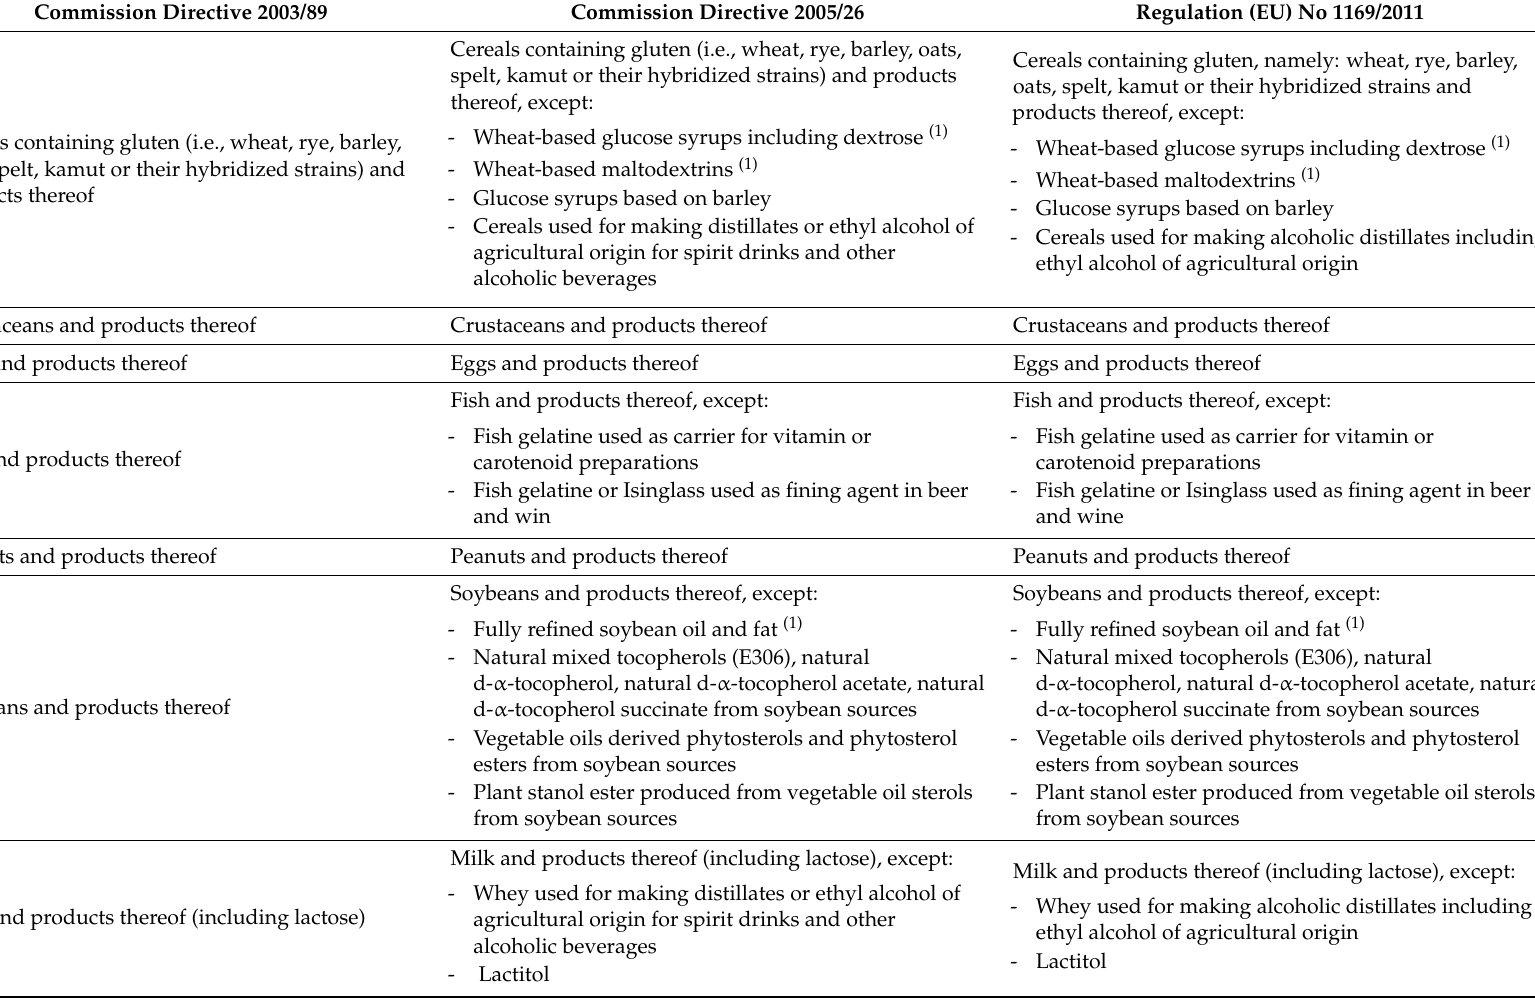
Table 1. Ingredients listed in the Annex IIIa of Directive 2003/89 that must be